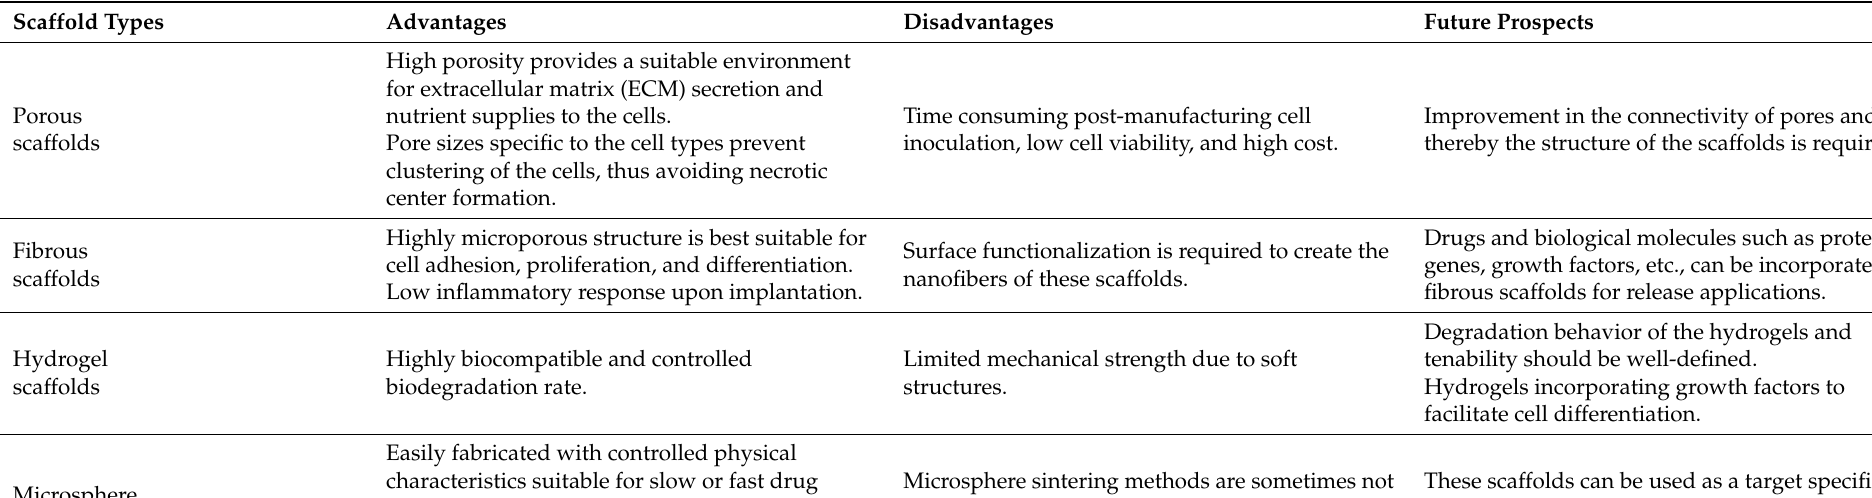
Table 1. Advantages and disadvantages of different scaffolds used in skin tissue